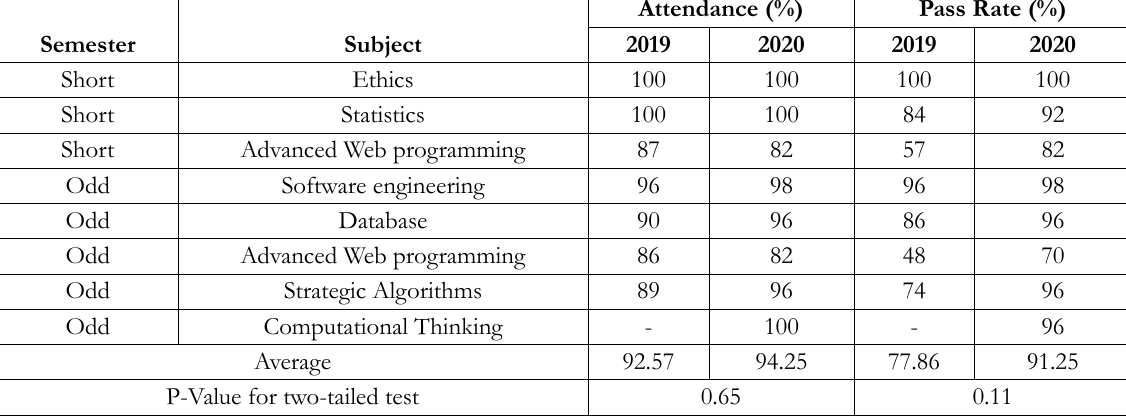
Table 4. Comparison of attendance and pass rate percentage of the courses during the study